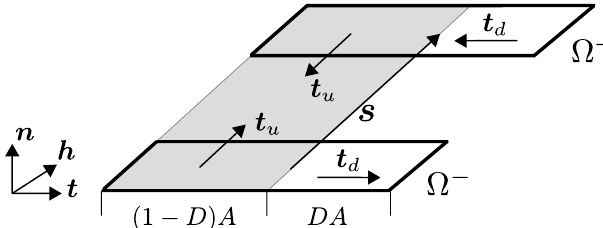
Figure 6. Schematic illustration of representative interface area